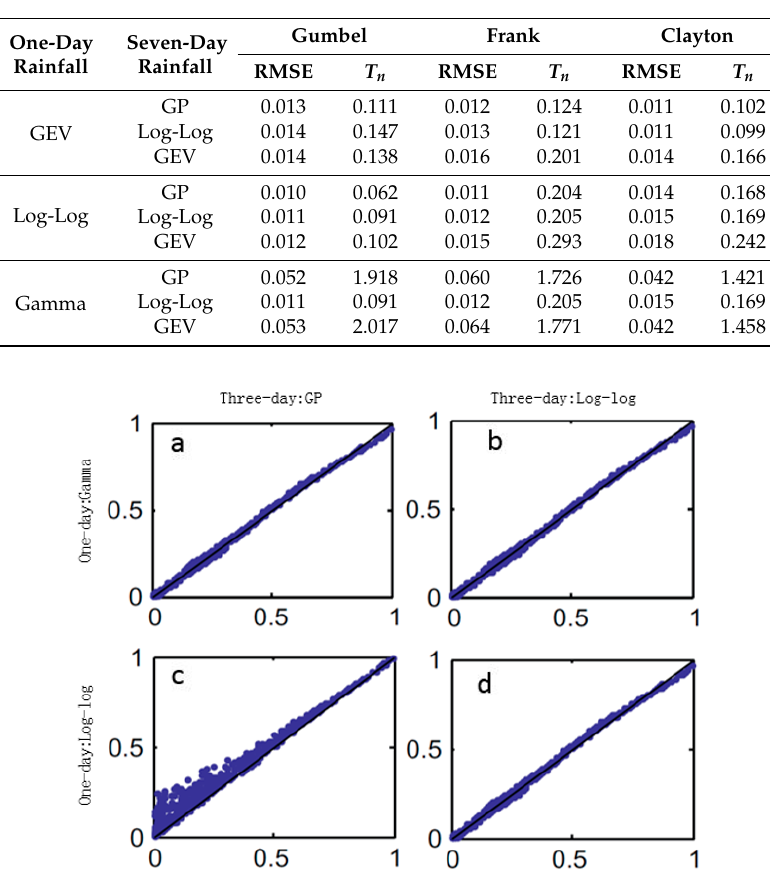
Table 7. Goodness-of-fit of the copulas for different combinations of marginal distributions of one-day and seven-day rainfall.